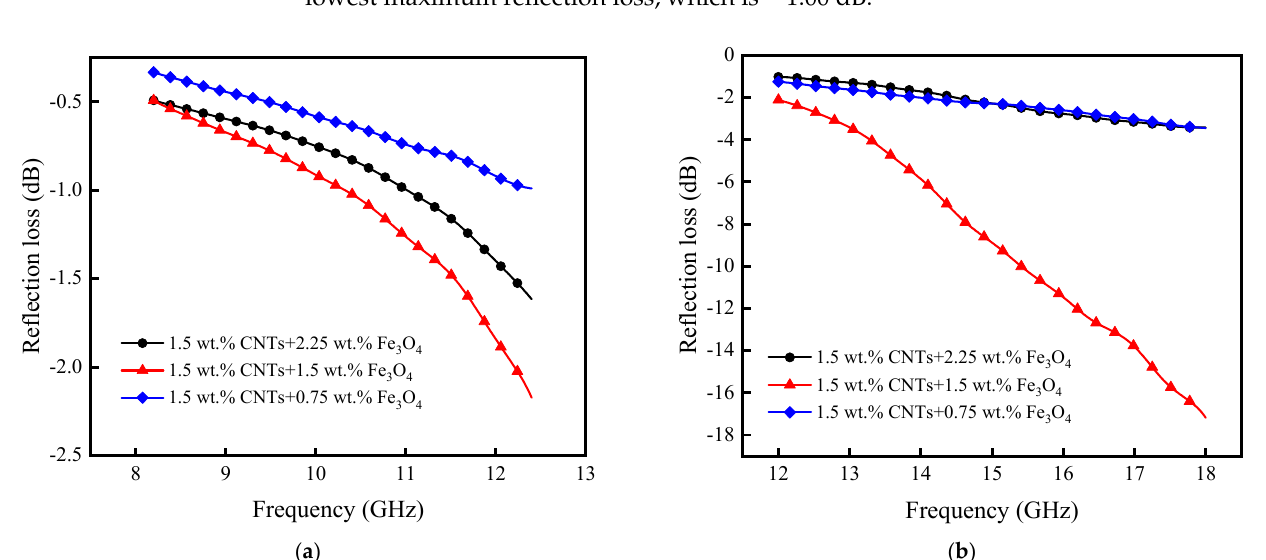
Figure 11. The influence of different mass ratio of CNTs and Fe 3 O 4 on microwave-absorbing performance of Fe 3 O 4 /CNTs/PU/PET gradient composites, with composites face down: ( a ) 8.2–12.4 GHz; ( b ) 12–18 GHz.